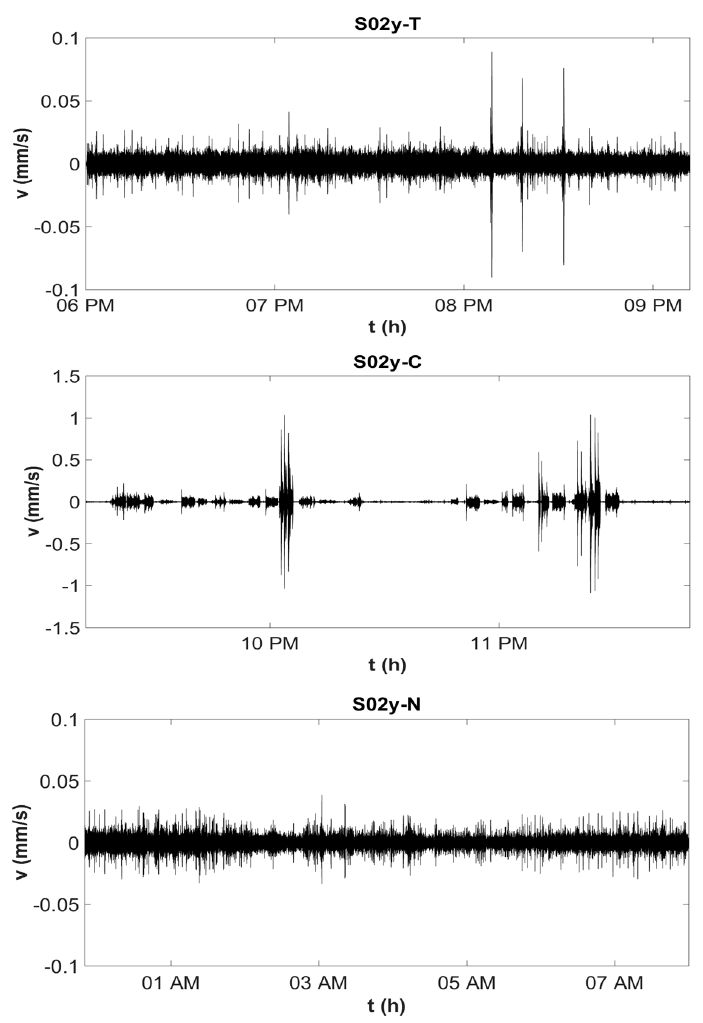
Figure 19. Time histories at S02y in the three time intervals (T, C, and N).